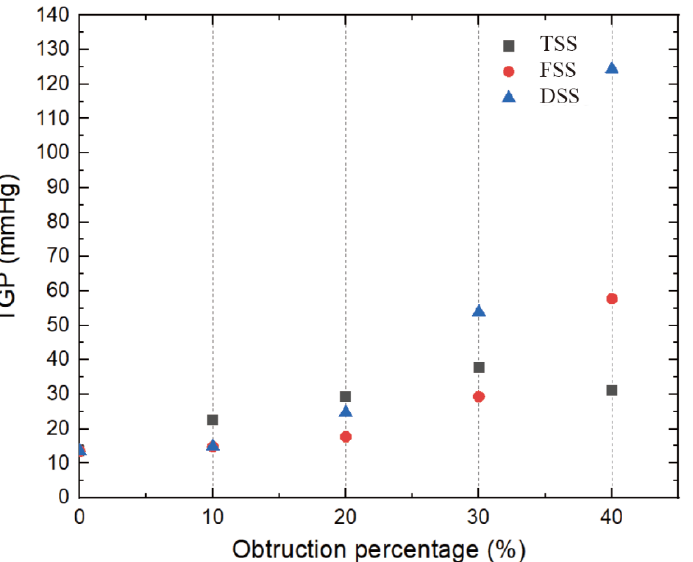
Figure 14. Mean transvalvular pressure gradient for three types of SAS at different obstruction percentages ( t = 0.2 s).